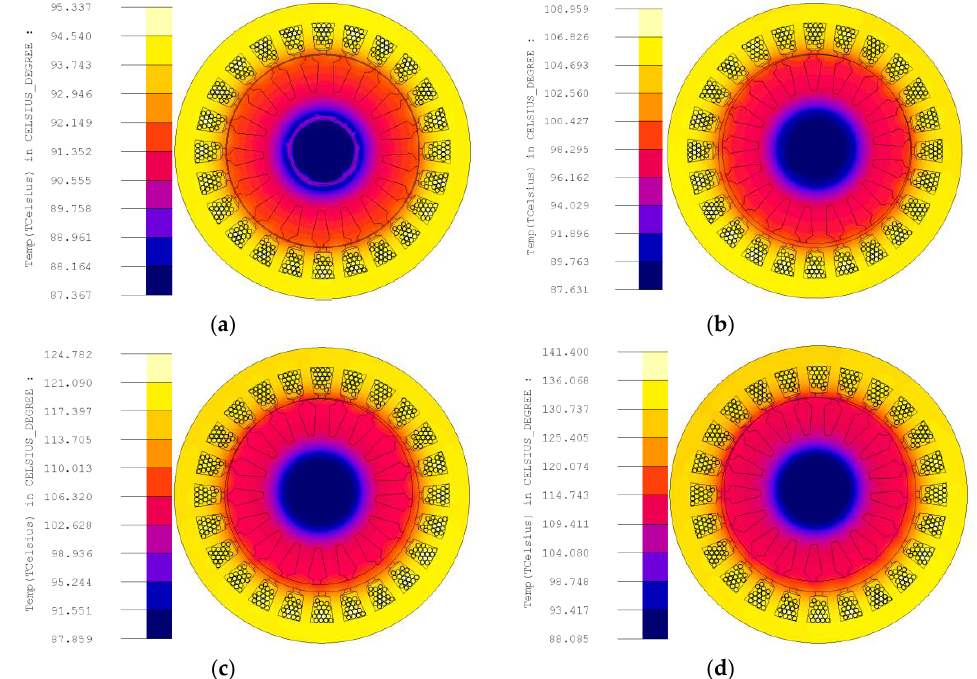
Figure 15. Thermal analysis of the ZAIM in the steady state regime for different values of the eccentricity: ( a ) e = 0 mm; ( b ) e = 0.5 mm; ( c ) e = 1 mm; ( d ) e = 1.5 mm.